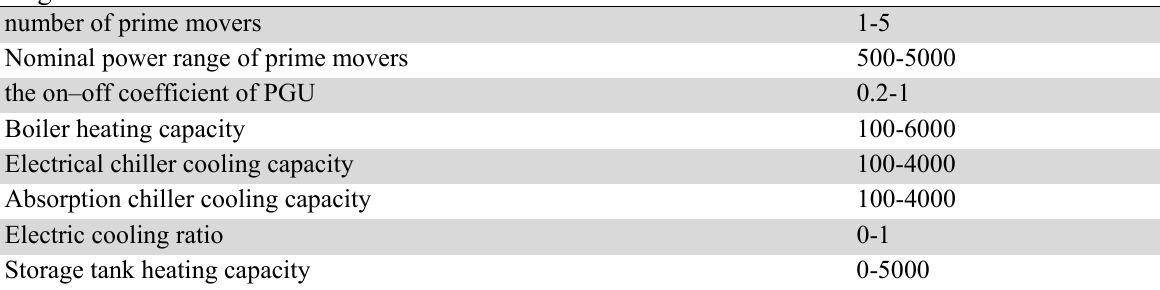
Range of variations of the decision variables.